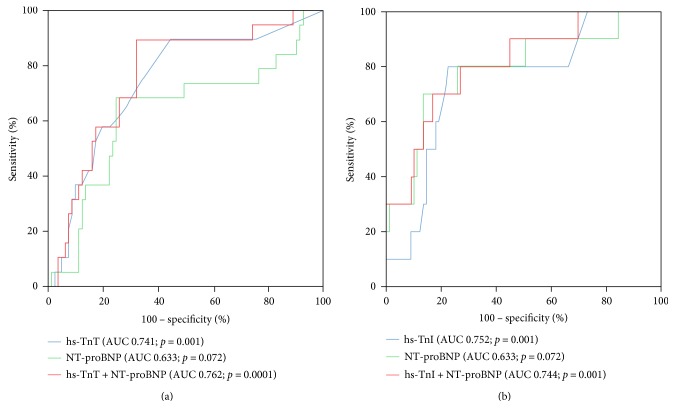
Receiver operating characteristic (ROC) curves demonstrating the capacity of hsTnT (a) and hsTnI (b) to discriminate significantly coronary artery plaques with mixed calcification.